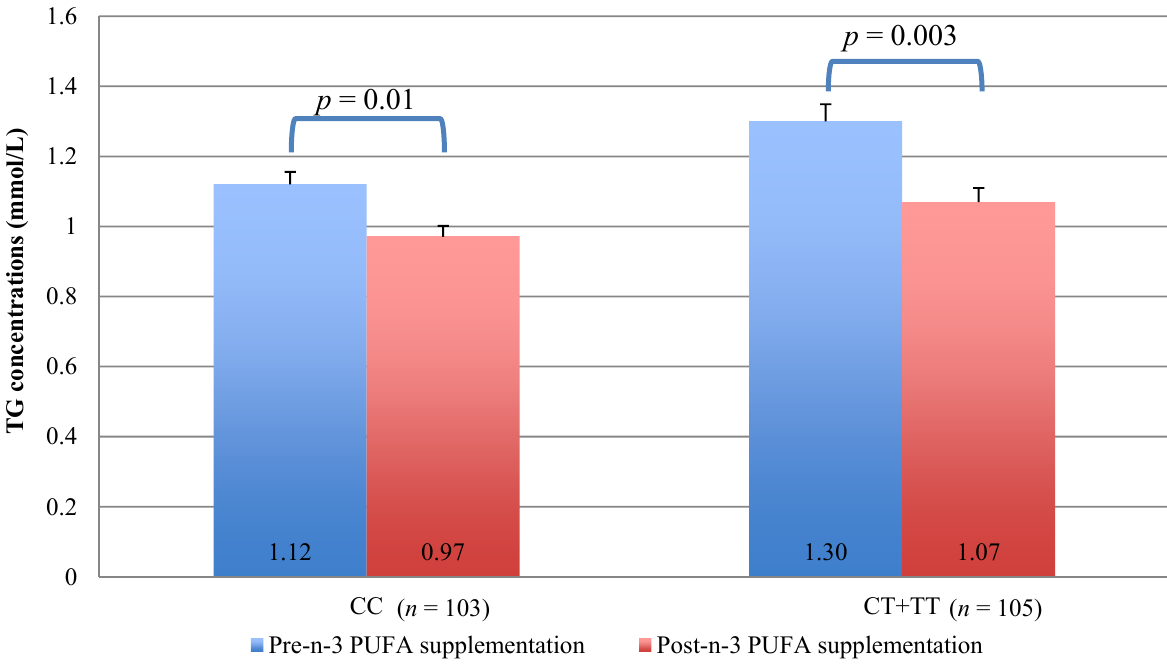
Figure 2. TG concentrations before and after a 6-week n -3 PUFA supplementation according to the SNP rs174546 in FADS